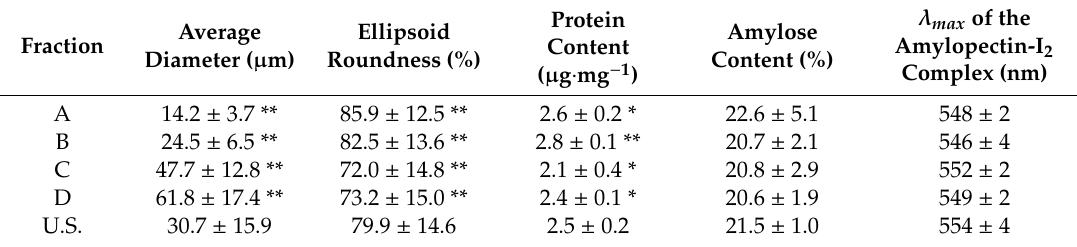
Table 1. Size, shape, protein and amylose contents and λ max of the amylopectin-I 2 complex. Statistics were performed by Student t-test compared to unfractionated starch (U.S.). * corresponds to P < 0.05 and ** to P <